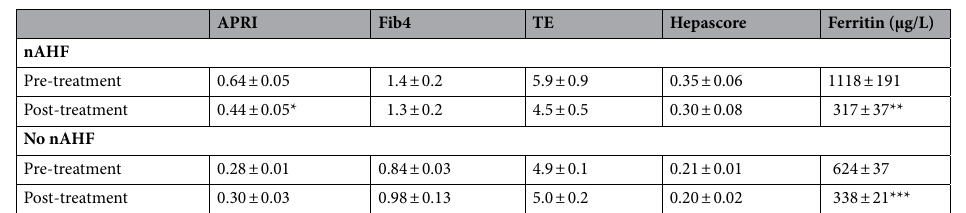
Table 3. Comparison of noninvasive biomarkers pre- and post-treatment in the subjects with either noninvasive biomarker-detected advanced hepatic fibrosis (nAHF) using APRI > 0.44 or no evidence of noninvasive biomarker-detected advanced hepatic fibrosis (no nAHF) using APRI ≤ 0.44 in Model 1. Results are shown as mean ± SE. APRI: aspartate aminotransferase to platelet ratio index; Fib4: fibrosis-4; nAHF: noninvasive biomarker advanced hepatic fibrosis; No nAHF: no noninvasive biomarker advanced hepatic fibrosis; TE: transient elastography. *P < 0.05, **P < 0.01, ***P < 0.0001 compared with pre-treatment (paired t